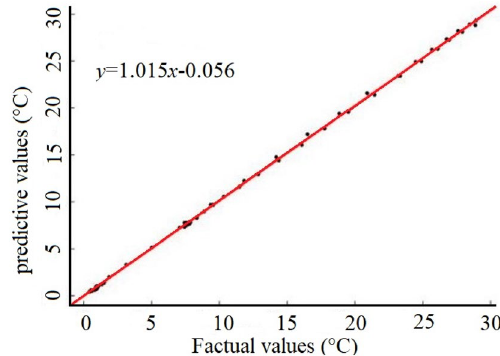
Figure 9. Temperature prediction of NARXNN.